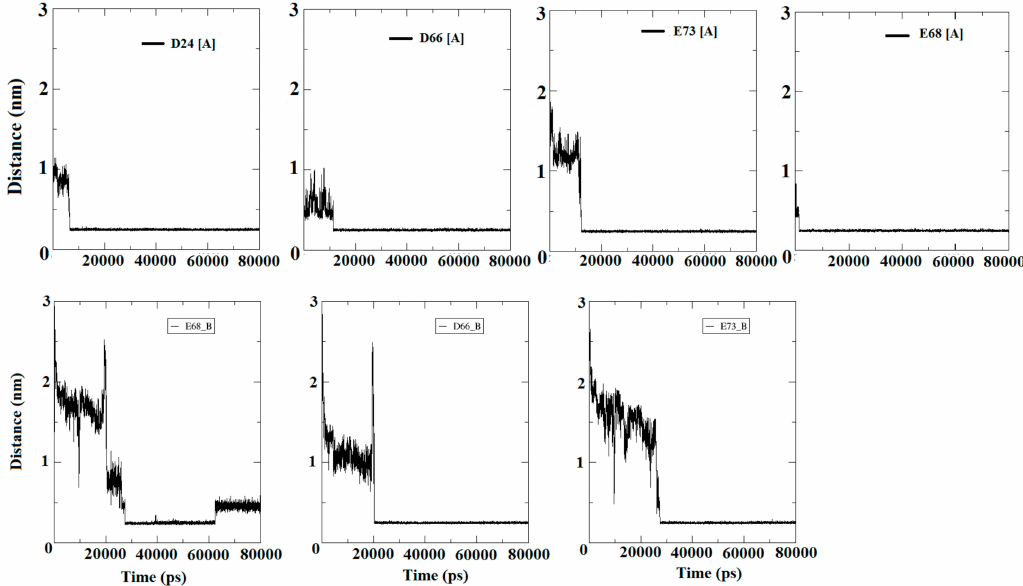
Figure 8. Distance calculations from Ca 2 + to specific residues listed in the above analysis. Residues and its identifiers given along with subunits A and B demonstrated four and three carboxylate moieties in subunit A and B, respectively. Each Ca 2 + reaches a significant distance between ~5 ns to 25 ns simulation time and maintains equivalence